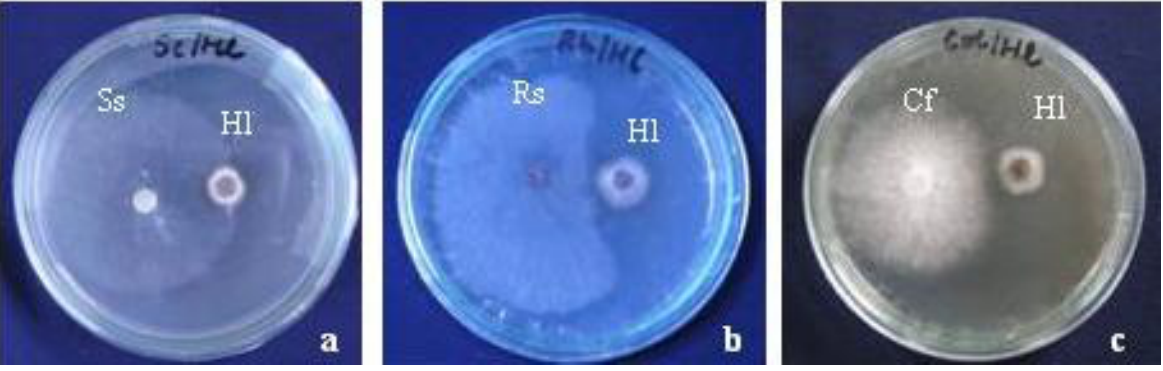
FIGURE 2. Inhibition of plant pathogenic fungi by Heliscus lugdunensis : (a) Sclerotinia sclerotiorum , (b) Rhizoctonia solani , (c) Colletotrichum falcatum